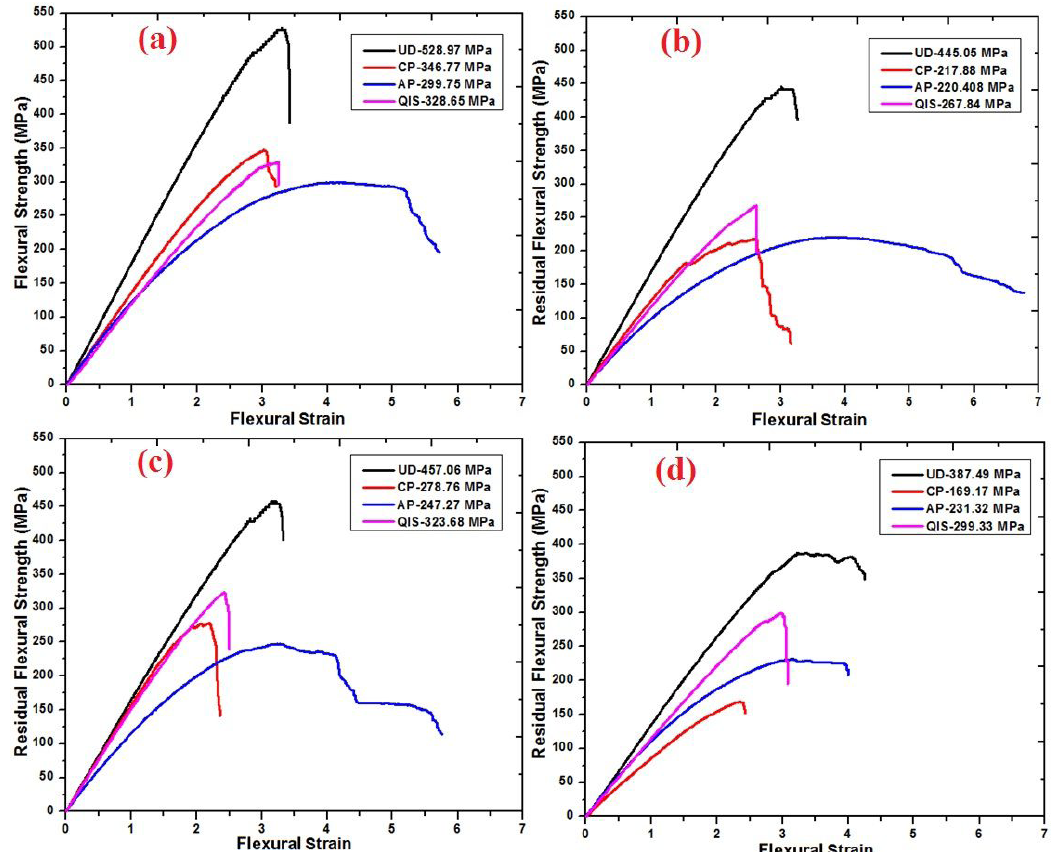
Figure 11. Estimation of residual flexural strength (a) Non-indented, (b) Indented at 0 o , (c) Indented at 10 o and (d) Indented at 20 o .